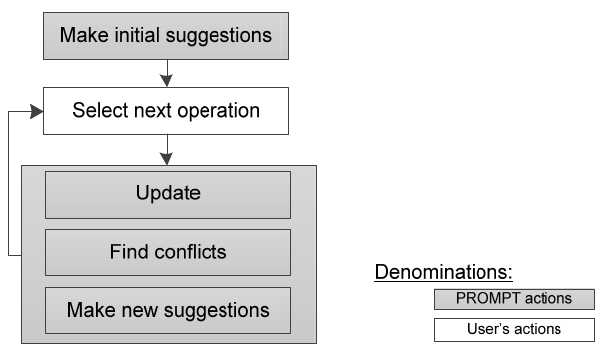
Fig. 3. Flow of the PROMPT algorithm